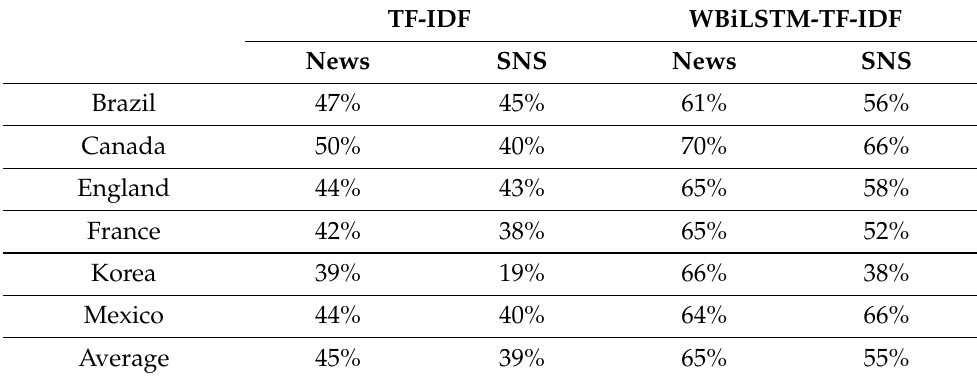
Table 2. Average accuracies of WBiLSTM-TF-IDF and